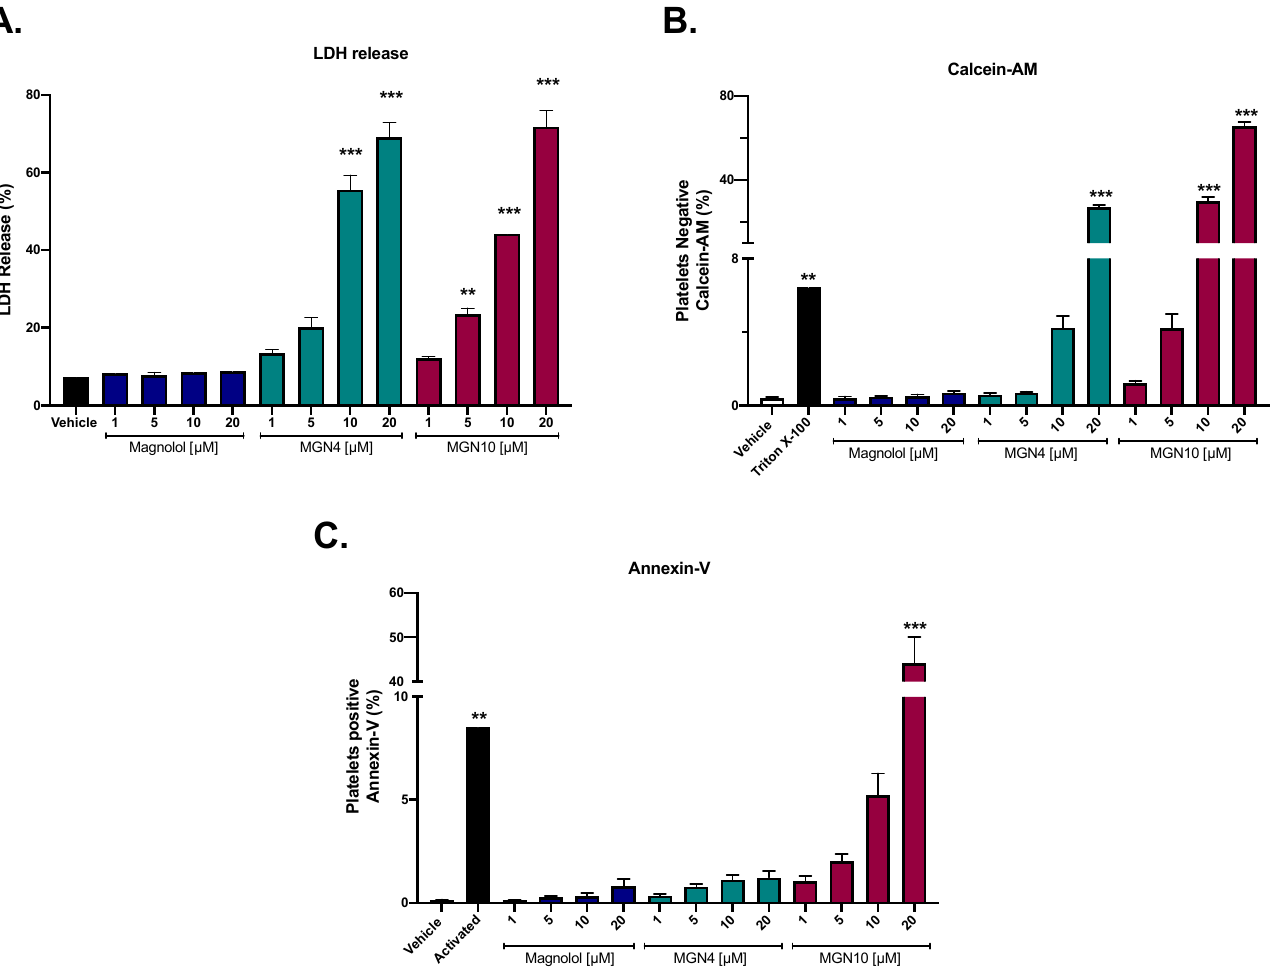
Figure 1. Platelet cytotoxicity and apoptosis. ( A ) LDH release from platelets. ( B ) Platelet viability by Calcein-AM. ( C ) Platelet apoptosis by Annexin-V. The results shown were obtained from at least five independent donors and expressed as the mean ± SEM. Vehicle: DMSO 0.4%. The statistical analysis was performed using a one-way analysis of variance (ANOVA) and the Bonferroni post hoc test. ** p < 0.01 and *** p < 0.001 vs. vehicle.